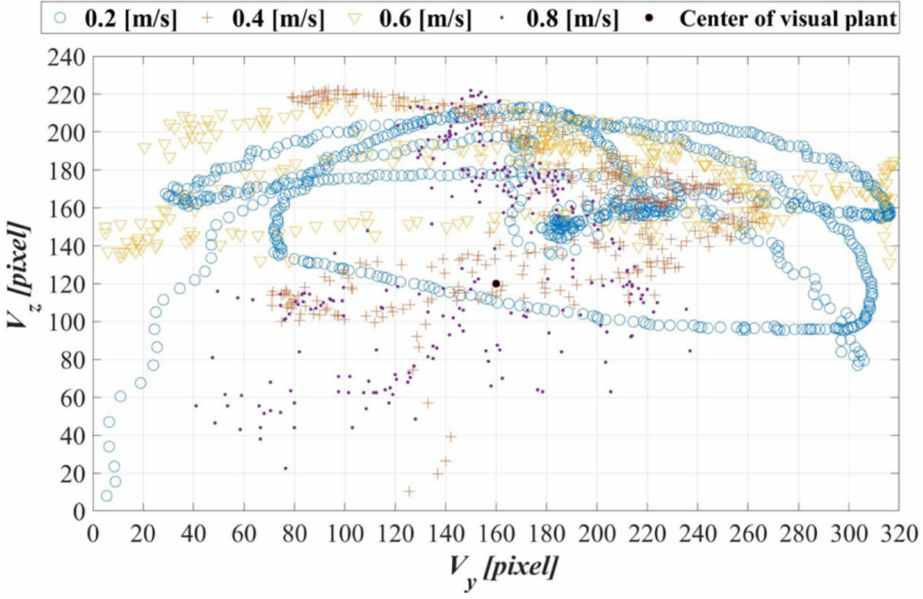
Figure 20. Image coordinate system logs of the AUV in dynamic guidance experiments with towing speeds of 0.2, 0.4, 0.6, and 0.8 m/s. Figure 21a,b present the statistical results of guidance experiments with towing speeds of 0.2, 0.4, 0.6, and 0.8 m/s. It is found in Figure 21a that the standard deviations of pixels. Furthermore, the standard deviations of | V z − V z , c | in Figure 21b are 25.09, 32.54, 39.89, and 28.11 pixels. Meanwhile, the results indicate that the mean values of are 74.33, 51.97, 37.96, and 34.84 pixels, whereas the ones of | V z − V z , c | are 43.97, 45.99,